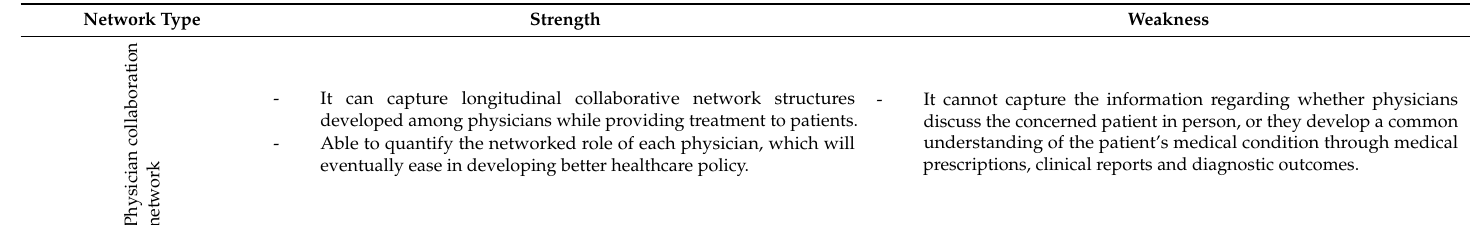
Table 4. The strength and weakness of di ff erent types of